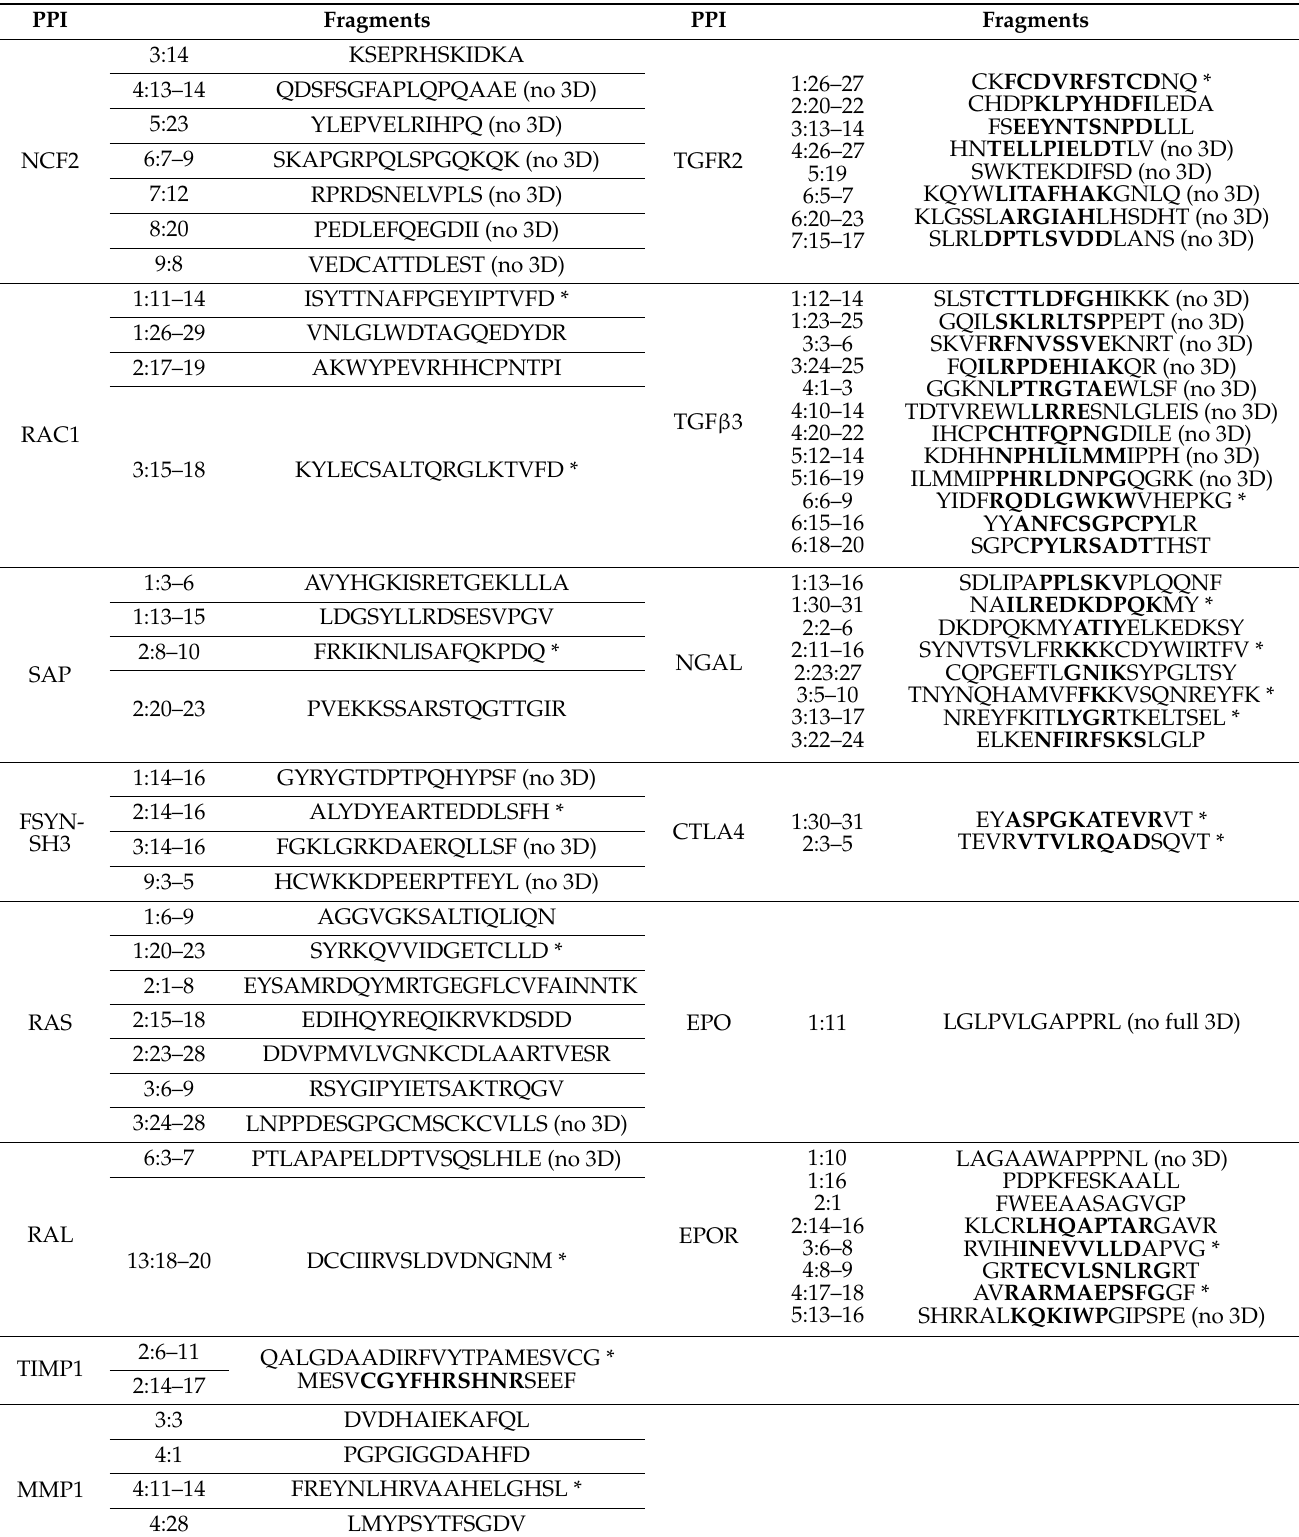
Table 2. Candidate fragments identified by PEPscan. For each protein, we report the positions that can be considered as positive in the membrane (x:y–z meaning line x, columns y to z), and the corresponding amino acid sequence, in which MOFs are in bold . Fragments at the 3D interface are labeled using a *. Protein fragments for which no 3D coordinates are available are labeled as “ no 3D